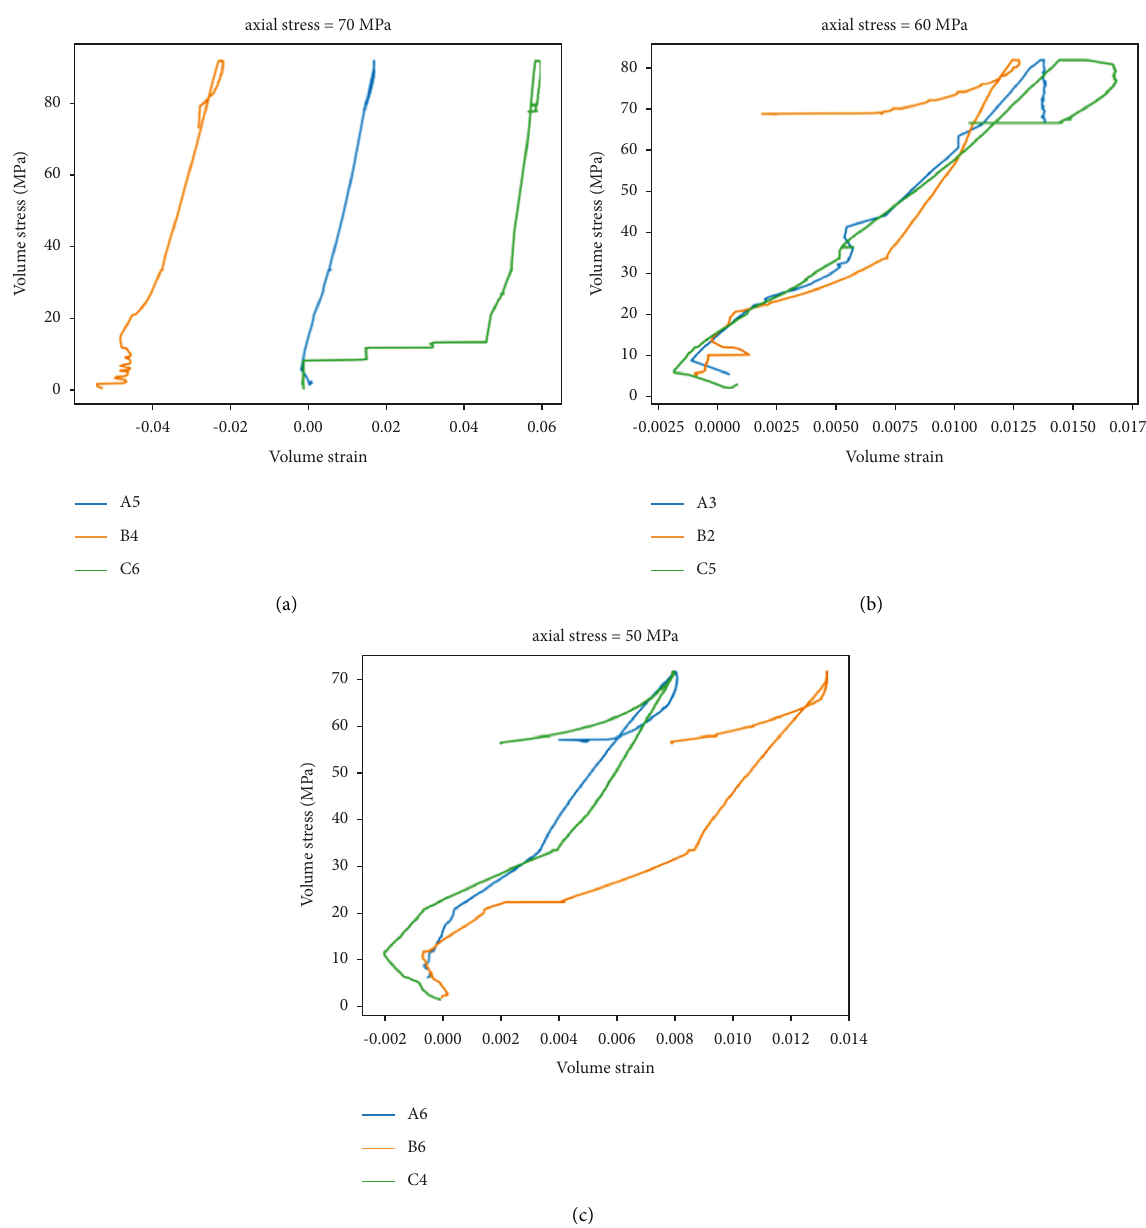
Figure 6: Volume stress-strain curve under different maximum vertical stress. (a) Maximum vertical stress stress 60MPa; (c) maximum vertical stress (cid:31)